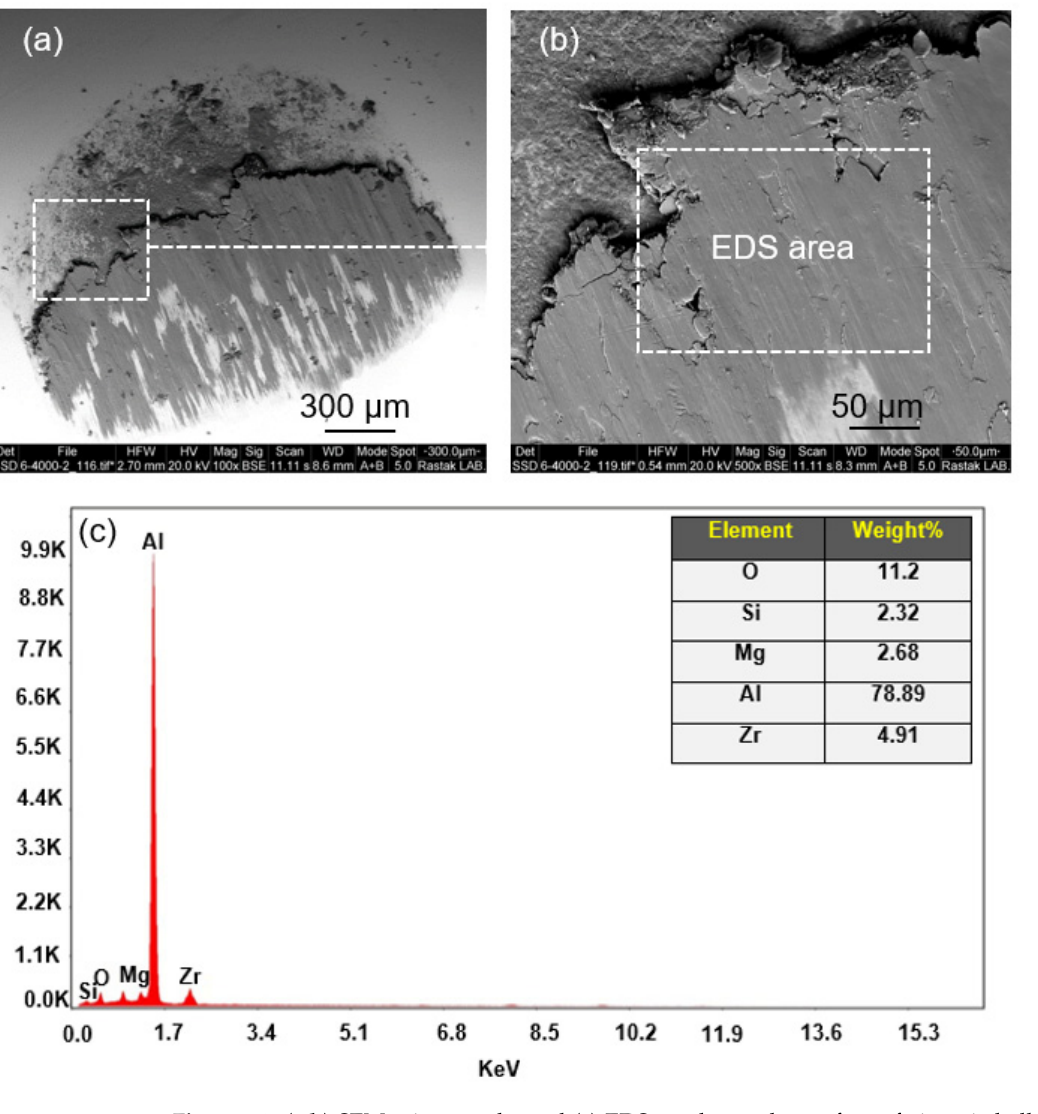
Figure 14. ( a , b ) SEM micrographs and ( c ) EDS results on the surface of zirconia ball used as the counter face against uncoated A356 substrate under 30 N applied load.